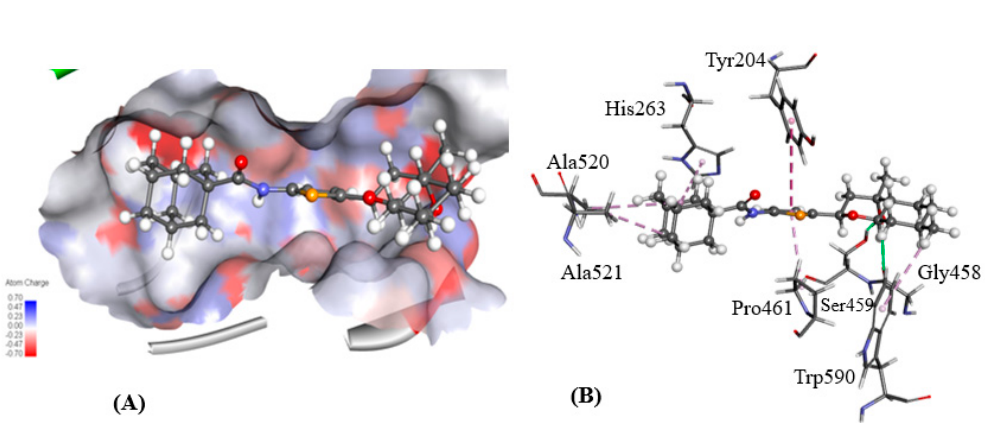
Figure 2. Docked configurations of derivative ( 4 S )- 13 to the substrate binding sites predicted by the ChemPLP algorithm. The protein surface is rendered where partial positive, negative charges, and neutral regions are colored blue, red, and grey, respectively ( A ). The hydrogen bond interactions are depicted as green lines between compound ( 4 S )- 13 and the amino acids residues; Ser459 and Gly458 ( B ). Furthermore, lipophilic contacts (LC) are shown as purple dashed lines with His263, Tyr204, Ala520, Ala521, and Pro461.